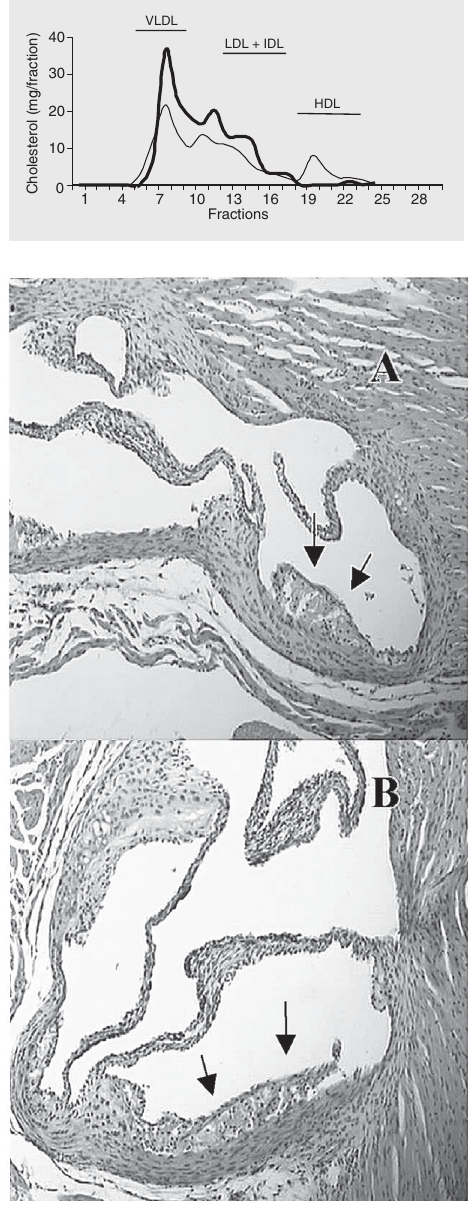
Figure 1. Lipoprotein profile of control (pool of 7 mice, fine line) or Lactobacillus delbrueckii apo- lipoprotein E knock-out mice (pool of 7 mice, bold line) after 6 weeks of the experiment (VLDL, fractions 6 to 9; LDL + IDL, frac- tions 10 to 19; HDL, fractions 20 to 26).